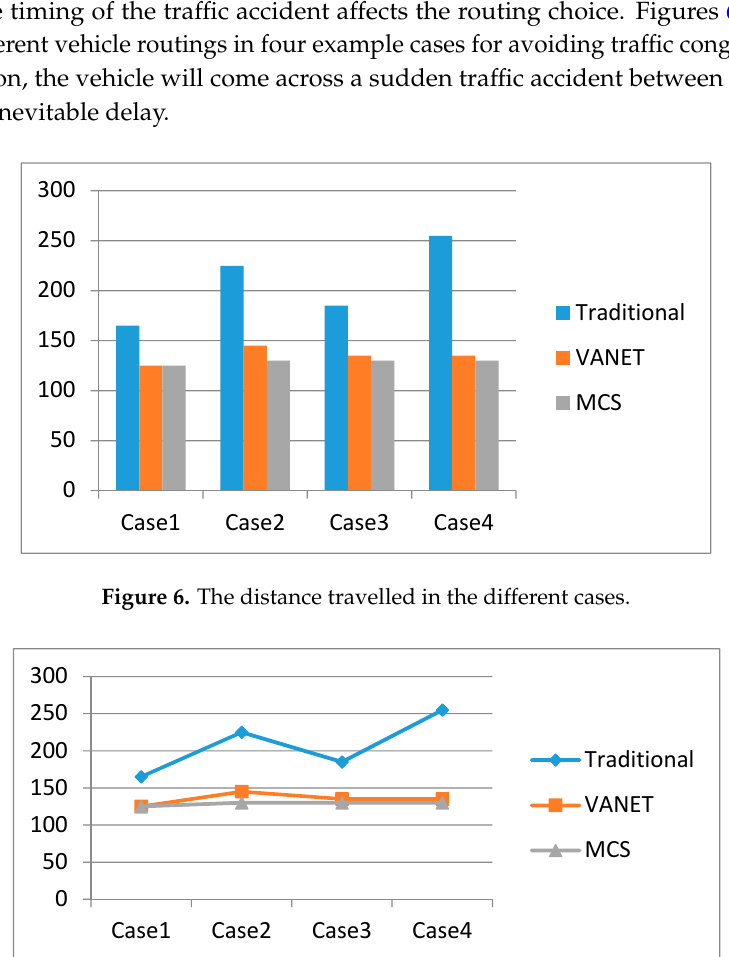
Figure 4. The distance of route segments from A to B